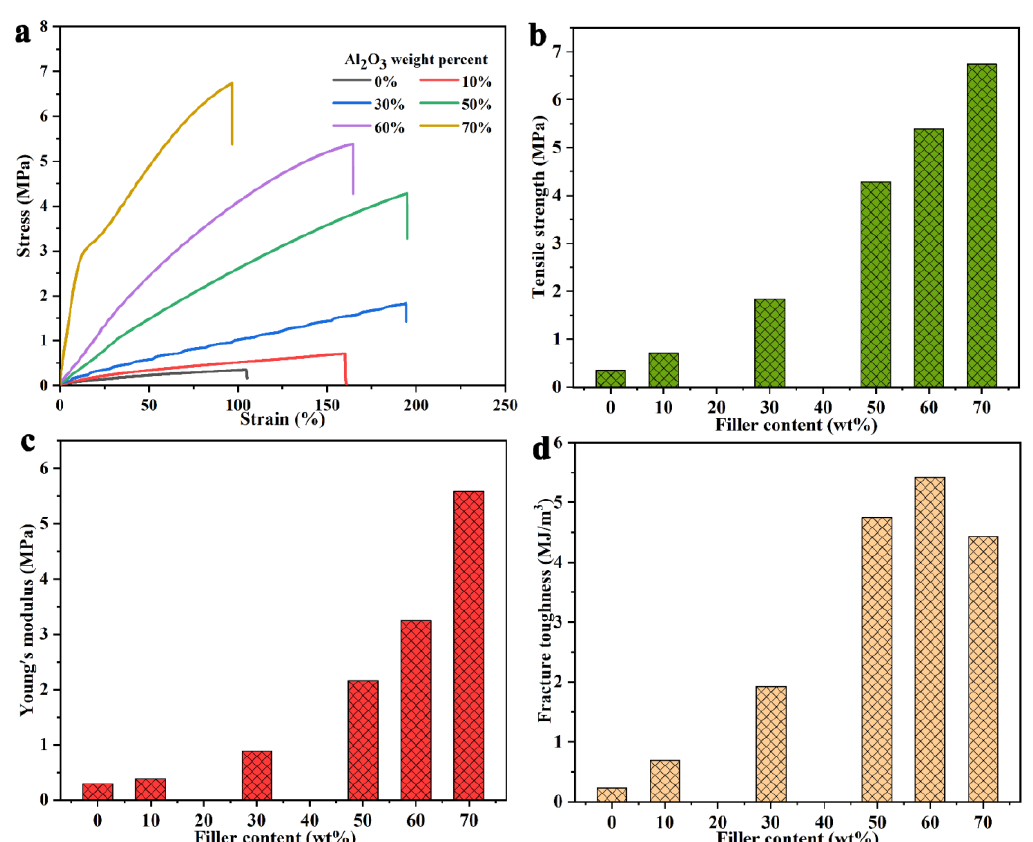
Figure 8. ( a ) Stress–strain curves, ( b ) strength, ( c ) modulus and ( d ) modulus of toughness of neat SR and Al 2 O 3 /SR composites.